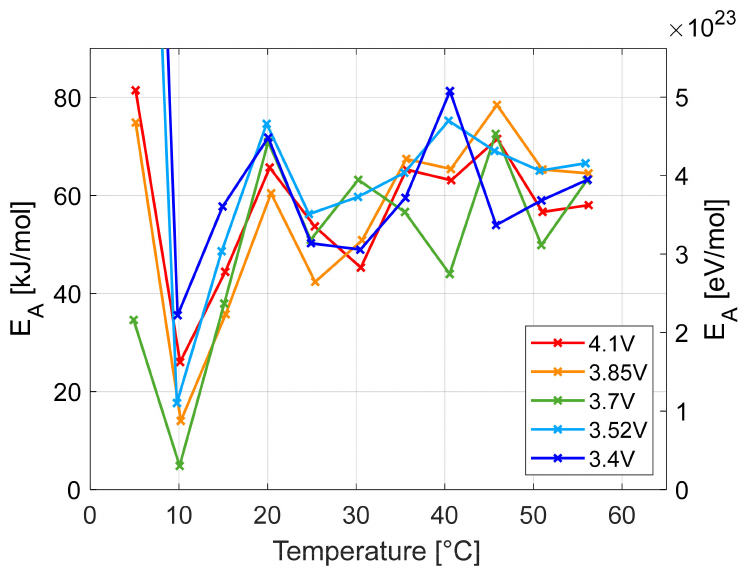
Figure 10. Activation energy EA over temperature in the range of 5–60 ◦ C setpoint temperatures. A representation of the float current over the cell voltage for different setpoint tem- peratures is given in Figure 11 The float current increases with temperature and with cell voltage but the increase over the cell potential is not smooth but increases in at least two different slopes. The cell potential at the transition between these parts shifts to lower potential with increasing temperature. Therefore, the optimum maximum voltage to reduce strong aging at a given temperature can be determined to guarantee long